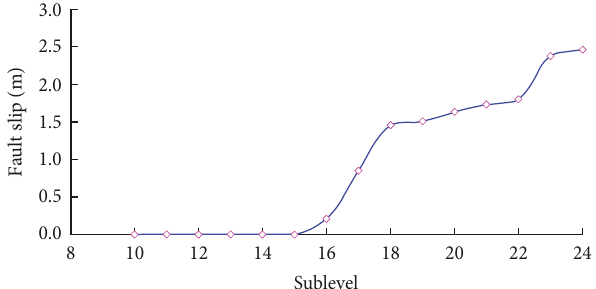
Figure 12: Relationship of slip amount of fault F3 with mining depth.